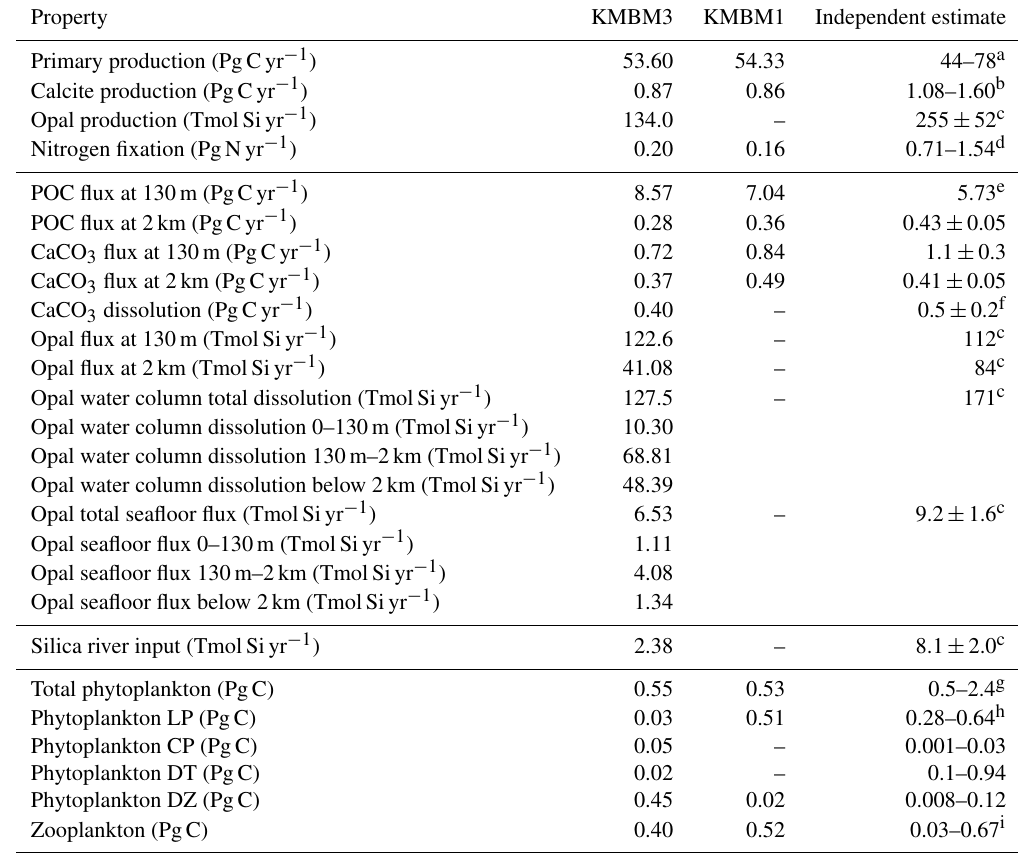
Table 6. Globally integrated diagnosed biogeochemical properties at the year 2004. Corresponding values are also given using KMBM1 (Keller et al.,